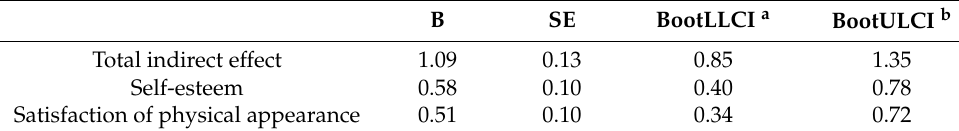
Table 4. Bootstrapping